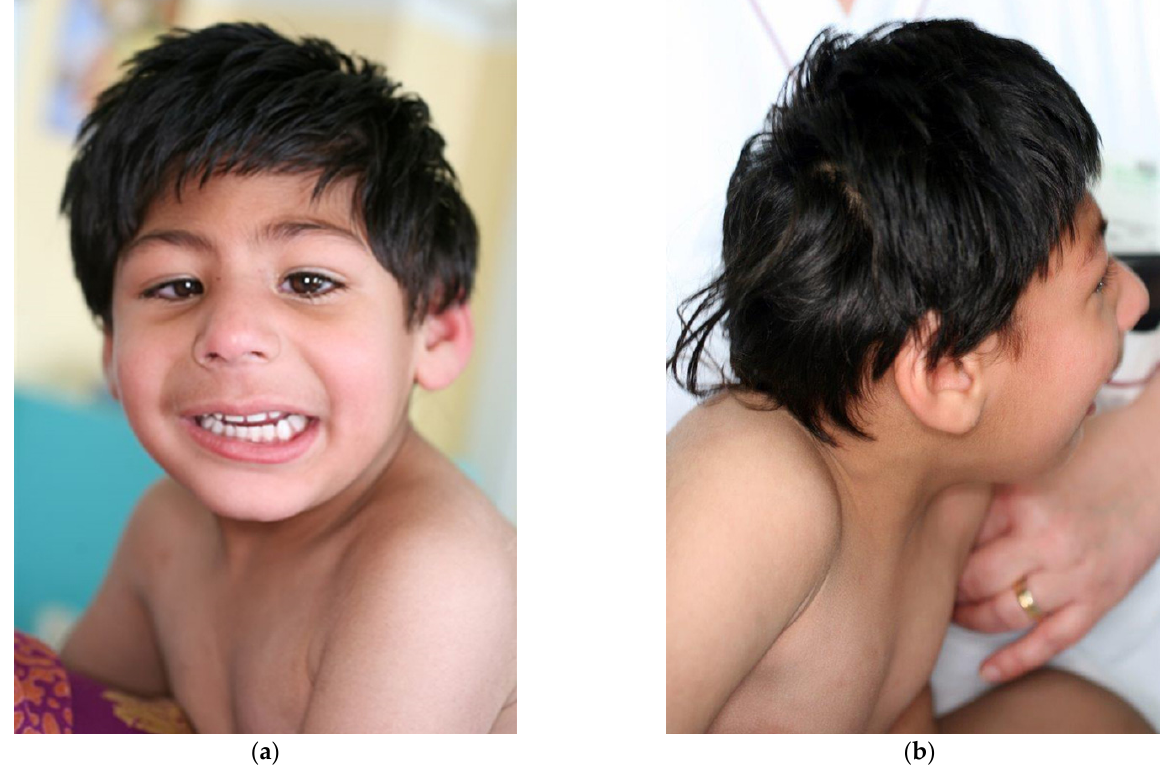
Figure 3. Facial features of our patient at 4 years 7 months of age: ( a ) front, ( b )